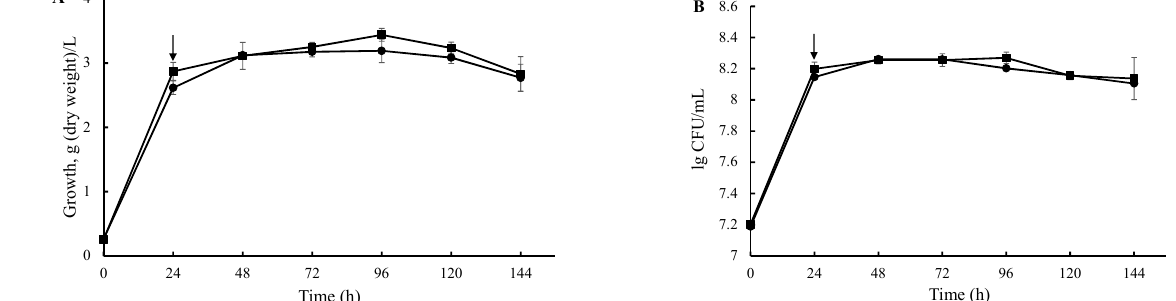
Figure 4. Growth of S. hirsuta in a rich (GSMY) medium. ( A ) S. hirsuta growth in a rich medium in the absence (circles) and presence of cholesterol (squares) (1.5 mM) measured by dry weight; ( B ) CFU count in the dynamics of incubation S. hirsuta in the rich medium in the presence of cholesterol (1.5 mM) (squares) or without steroids (circles). Arrows indicate the addition of